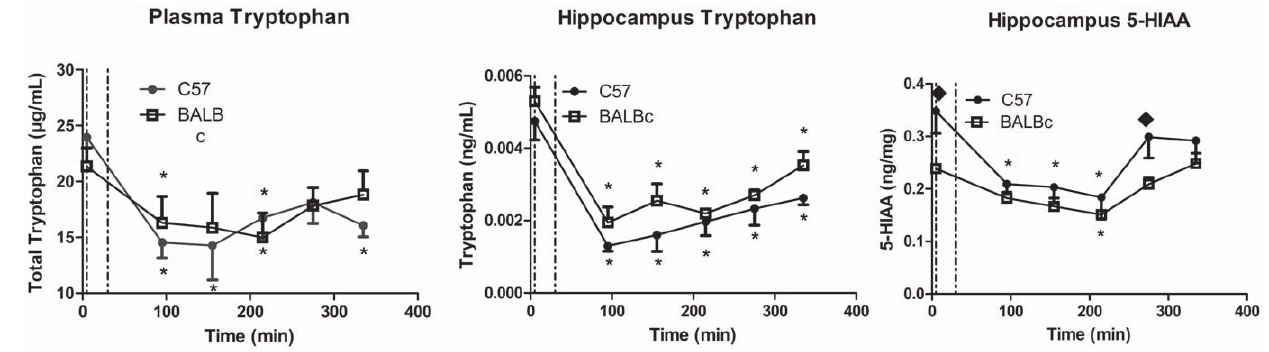
Figure 1. Time course of ATD Moja-De in both strains. (a) Plasma=plasma tryptophan ( m g/ml plasma) (b) HPC TRP=tryptophan in hippocampus ( m g/mg tissue) (c) HPC-5-HIAA=5-HIAA in hippocampus (ng/mg tissue). N=3–4/group for C57, N=4–8/group for BALBc. * different from Time 0 and ¤ different from corresponding group in BALBc mice.